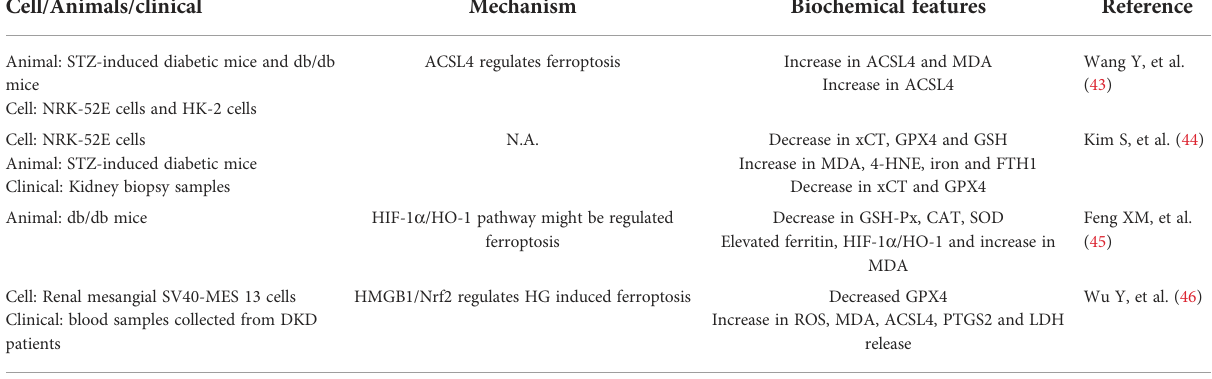
TABLE 1 Mechanism and biochemical features of ferroptosis in